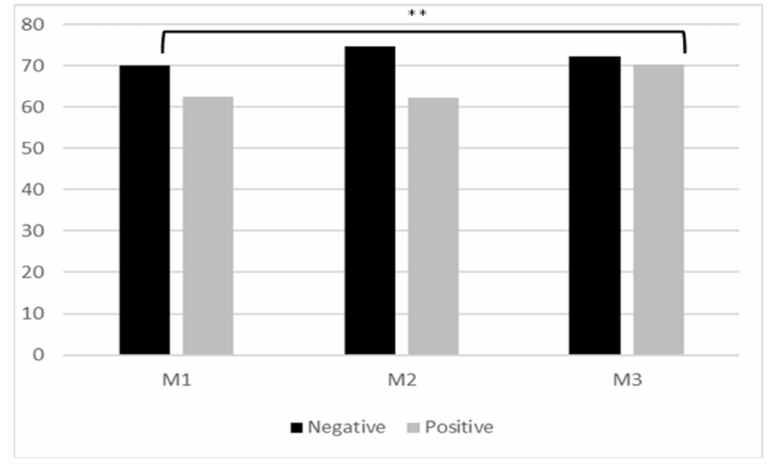
Figure 3. Kogan’s score in negative and positive subscales throughout the study. M1: Moment 1; M2: Moment 2; M3: Moment 3; ** p <